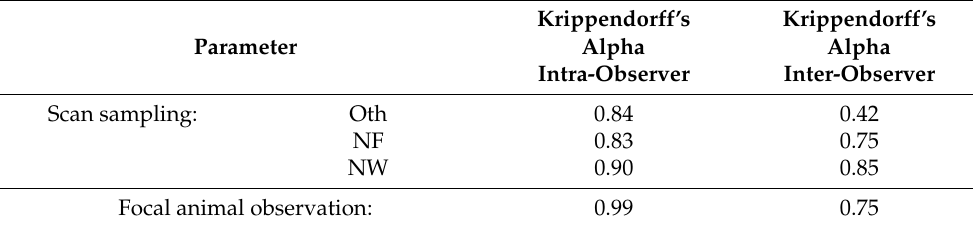
Table 2. Observer reliabilities for scan sampling ( n = 60 scans) and the focal animal observation ( n = 10